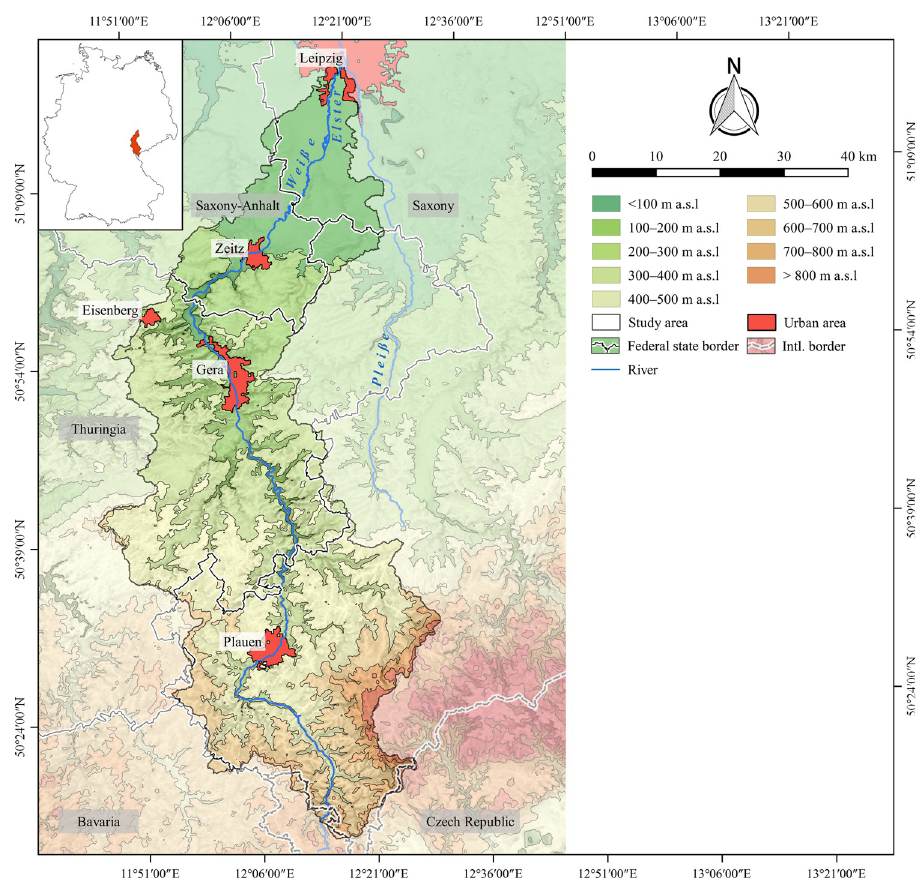
Fig 2. Study area with respect to borders of federal states, international (intl.) borders, local topography and large urban areas mentioned in the text. The outlines of the study area were extracted from the Catchment Characterisation Model database [82]. The political borders are drawn according to the Saxon State Office for Environment, Agriculture and Geology, the Saxony-Anhalt State Office for Surveying and Geoinformation and the Thuringian State Office for Land Management and Geoinformation. Rivers and urban areas are derived from the urban morphological zones dataset and the European Catchments and Rivers network system [83]. The topography is based on the SRTM 90 m Digital Elevation Database version 4.1 [61–63]. Topography and rivers have been modified according to older topographic maps (S2 Fig).